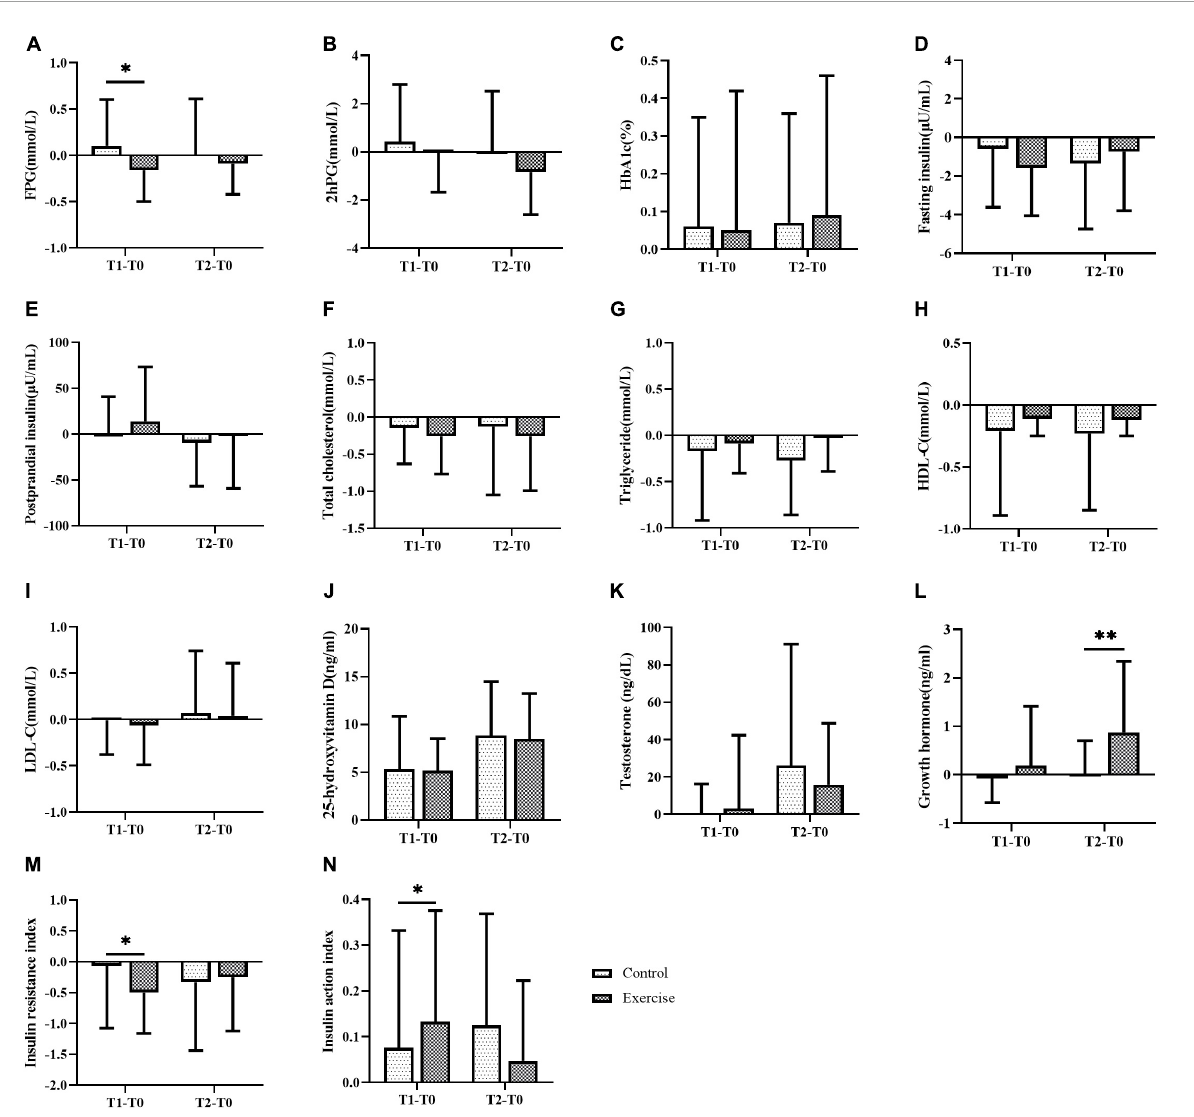
FIGURE4 Comparison of difference values between three or six months and baseline in different groups on glucose and lipid metabolism, (A–N) fasting blood-glucose, FPG (A) , 2–Hour post-meal blood glucose (B) , glycated hemoglobin% (C) , fasting insulin (D) , postprandial serum insulin (E) , total cholesterol (F) , triglyceride (G) , high density lipoprotein cholesterol (H) , low density lipoprotein cholesterol (I) , 25–hydroxyvitamin D (J) , testosterone (K) , growth hormone (L) , insulin resistance index (M) , insulin action index (N) . T1–T0 represents the difference value between three months and the baseline, and T2–T0 represents the difference value between six months and the baseline. * represents p < 0.05, ** represents p < 0.01. The title and note of all